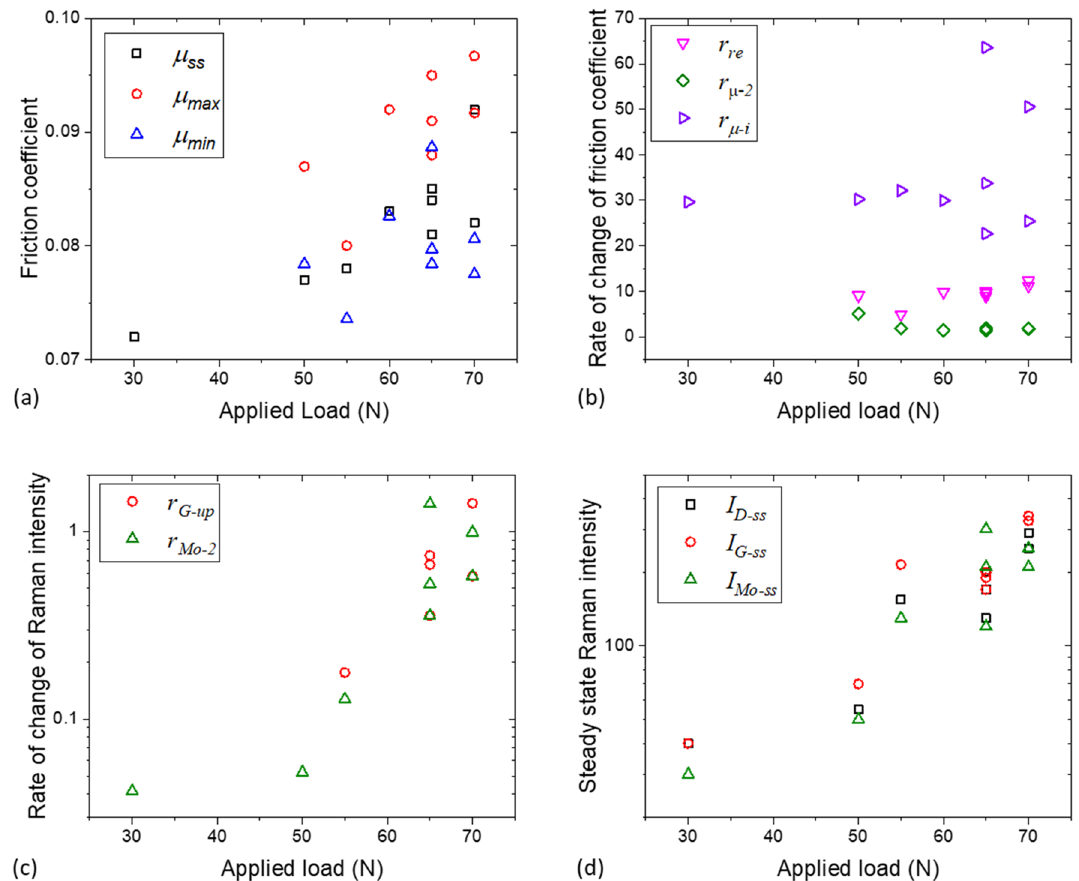
Figure 8. The effect of applied load on ( a ) friction coefficient; ( b ) rate of change of friction coefficient; ( c ) rate of change of intensity of MoS 2 and carbon G-band Raman peaks; and ( d ) intensity of MoS 2 and carbon G-band Raman during the steady state. Test temperature = 110 °C.